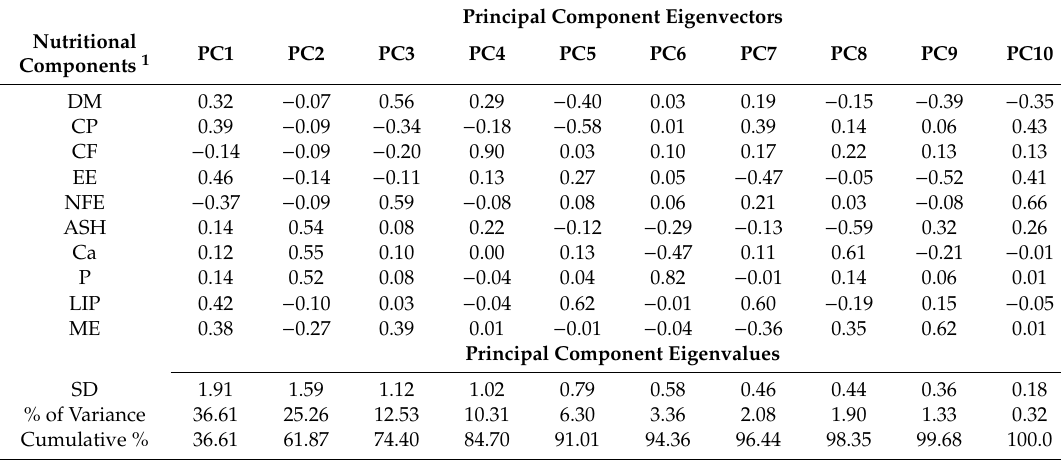
Table 1. Summary table of principal component analysis (PCA), indicating importance of each nutritional component in the diets preferred in kennel dogs, standard deviation, and the percentage of explanation of variation linked to each principal component.